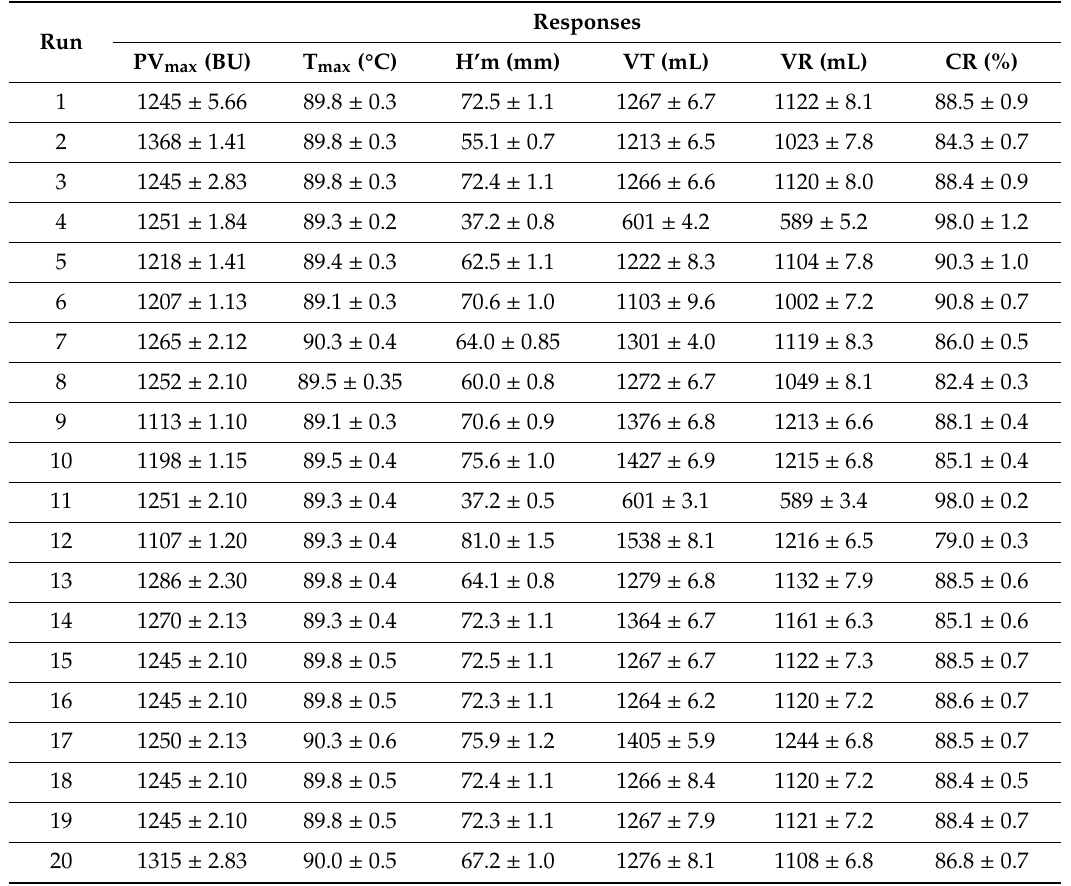
Table 3. The e ff ects of di ff erent levels of independent variable addition on dough rheological